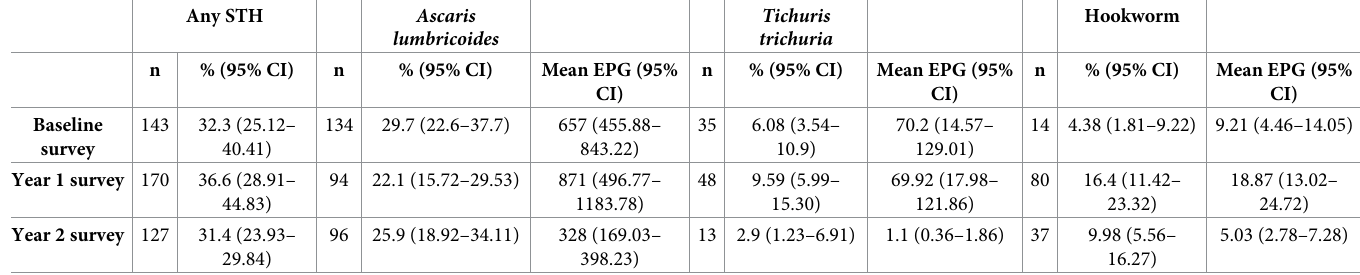
Table 2. Infection prevalence recorded across STH species and yearly sentinel site surveys. The symbol % represents the percentage positive in each group. CI = Confidence interval. EPG = eggs per gram of faeces. STH = soil-transmitted helminths. Any